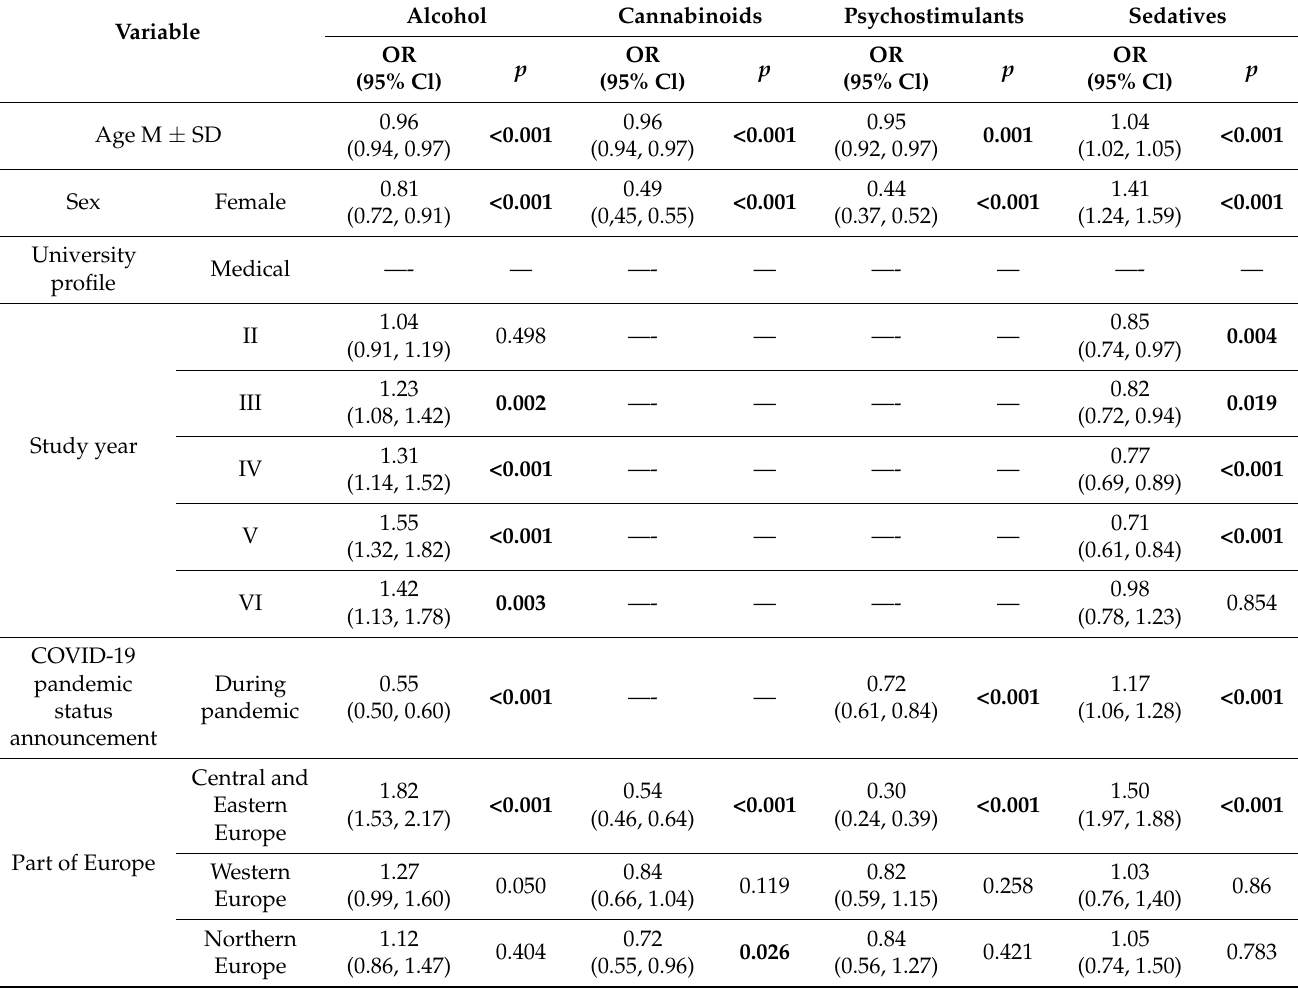
Table 3. Complex logistic regression model showing the impact of age, gender, university profile, studying year and area, and the impact of COVID-19 pandemic on the consumption of alcohol, cannabinoids, psychostimulants and